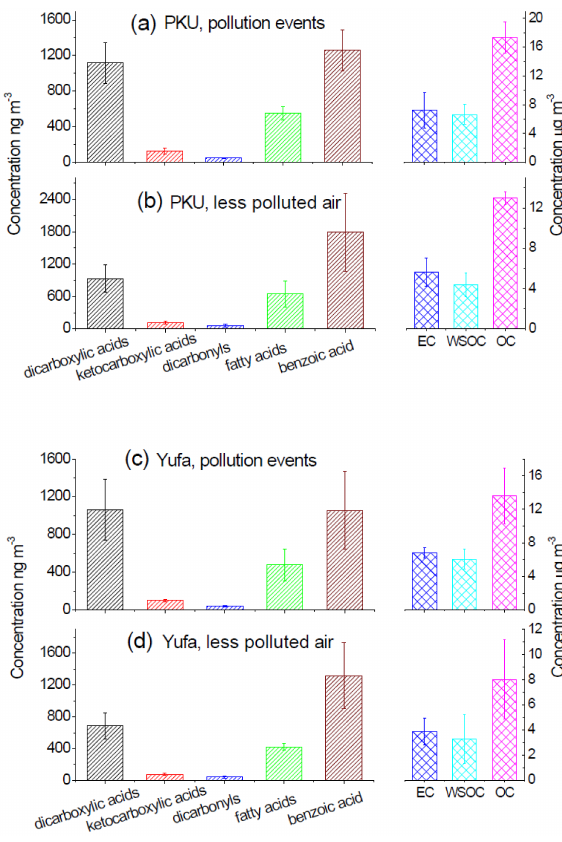
Figure 3. Pollution events vs. less polluted air at PKU ( a and b ) and Yufa ( c and d ), showing the variation of particulate pollutants.